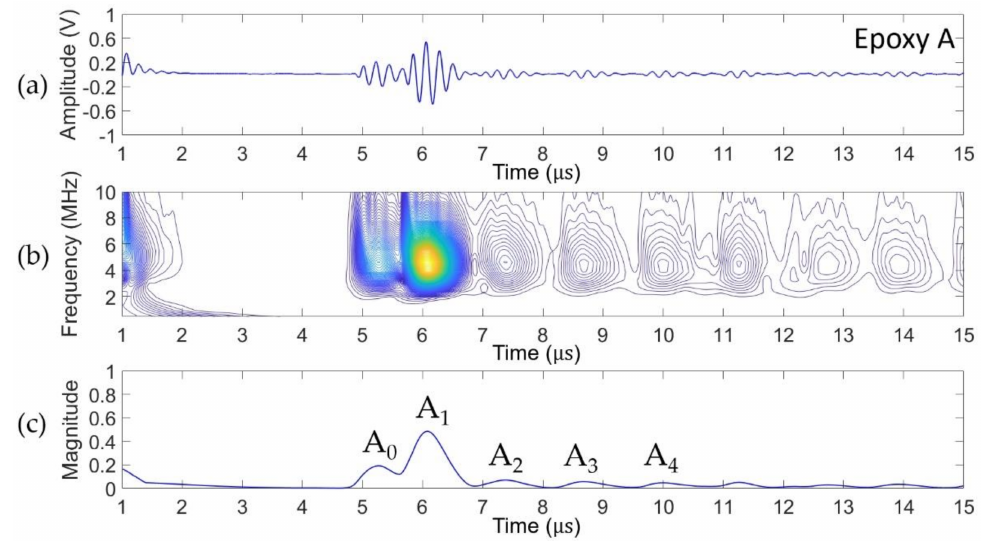
Figure 8. Ultrasonic signal from the perfectly bonded sections of the epoxy A: ( a ) time-domain waveform, ( b ) time-frequency representation of the waveform, and ( c ) the projection of STFT of the waveform into the time-domain.